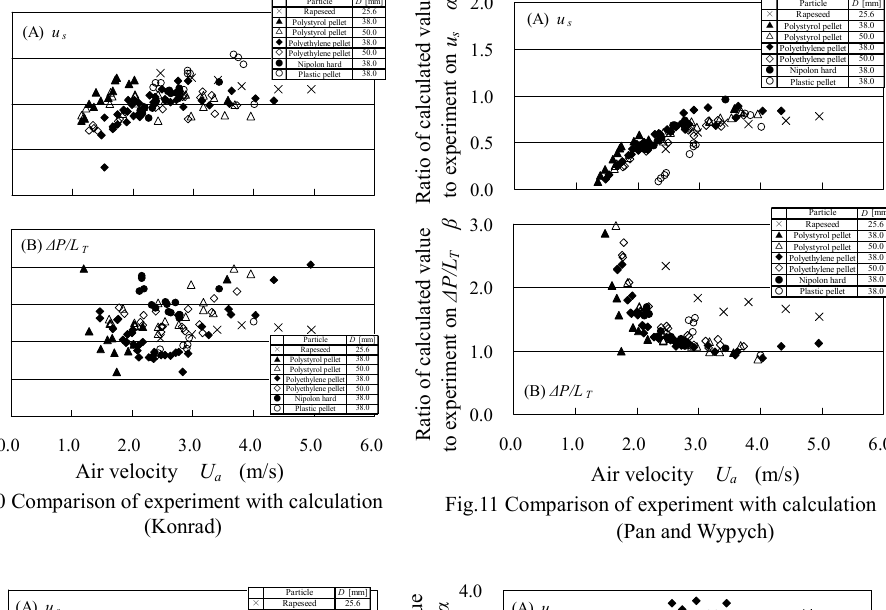
Fig.11 Comparison of experiment with calculation